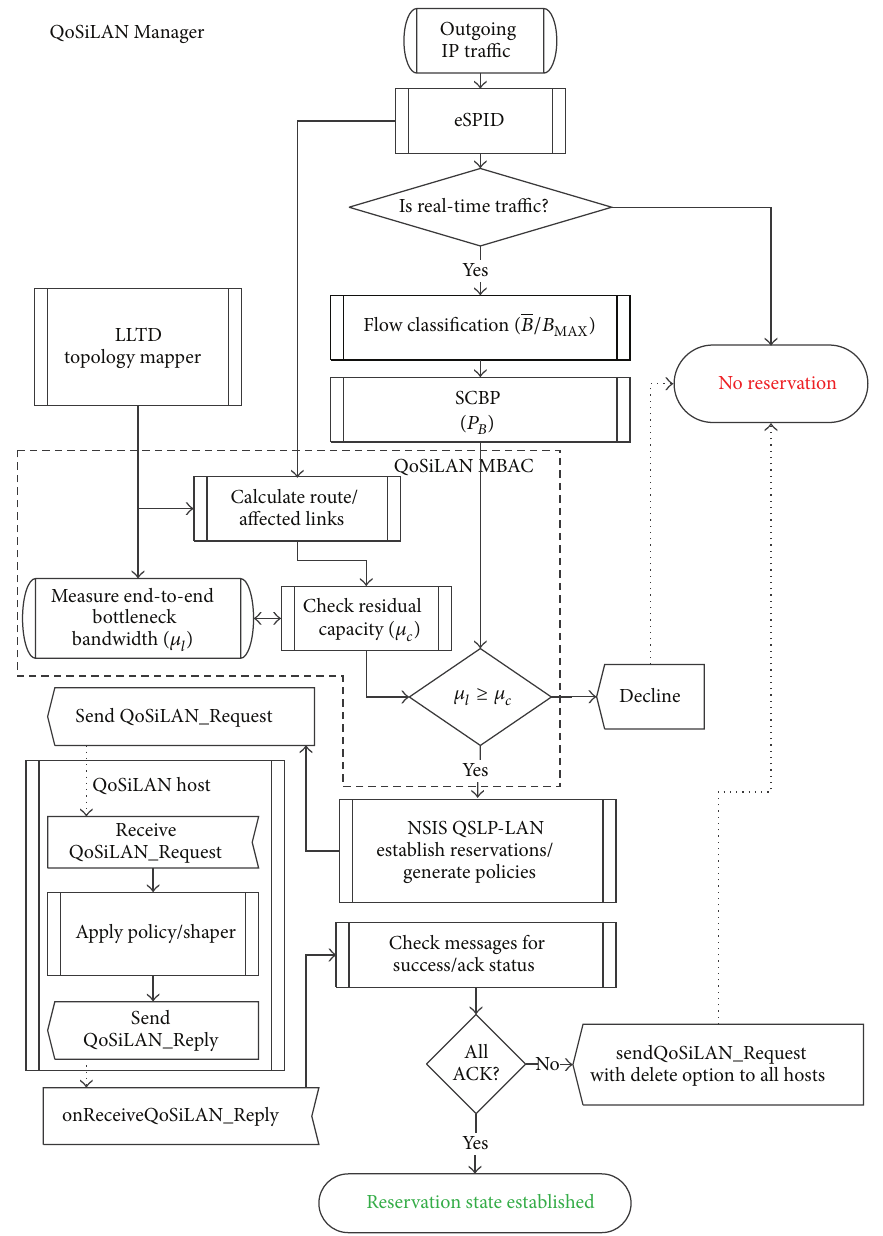
Figure 6: QoSiLAN policing information flow